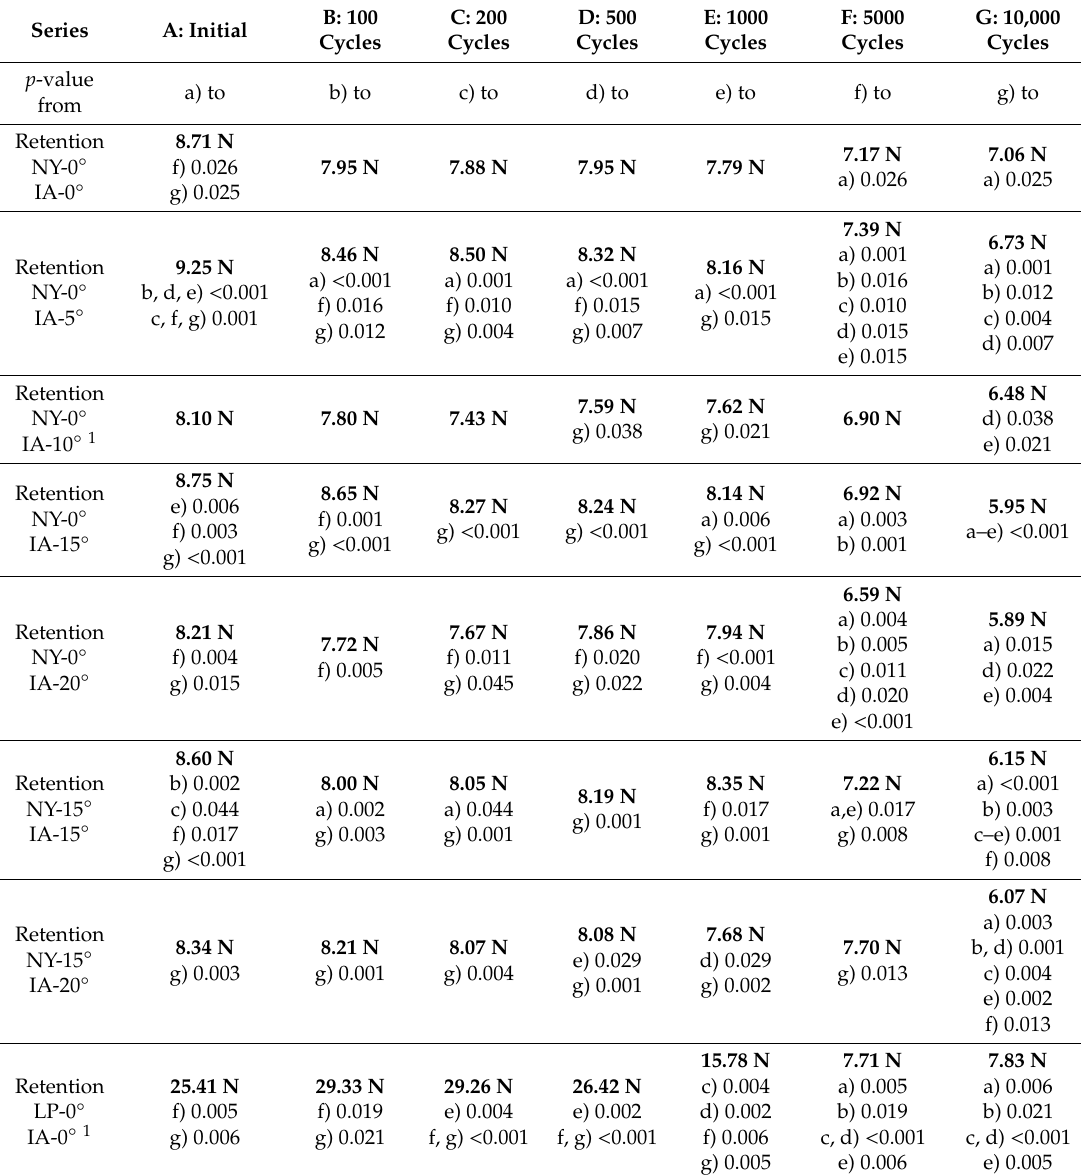
Table 3. Comparisons showing p -values ≤ 0.05 within a test series and ageing cycles; for